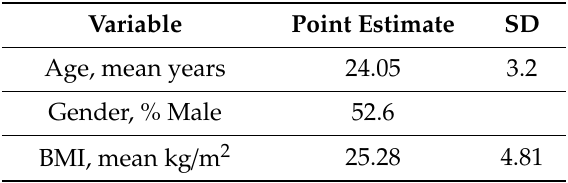
Table 1. Characteristics of the sample (N = 19).